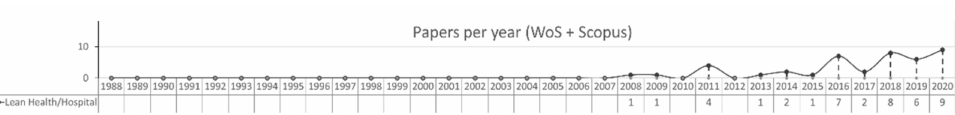
Figure 17. Lean healthcare/hospital